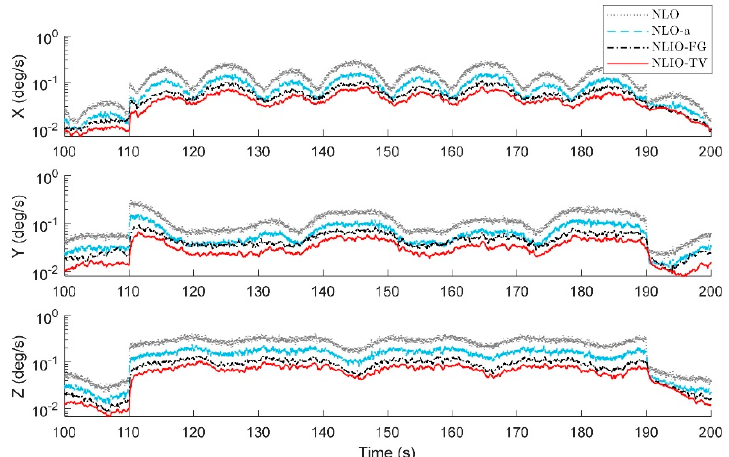
Figure 11. Averaged absolute gyro bias estimation errors between 100 s and 200 s over 100 simulations for Case 3.